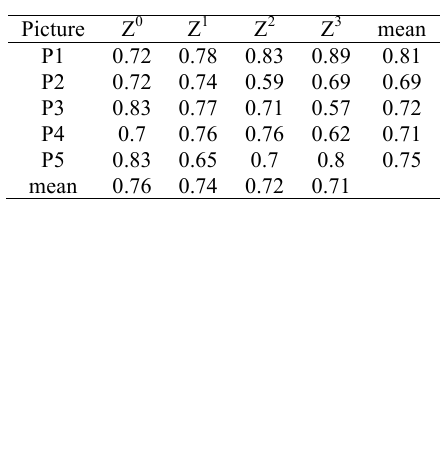
Table 6. Classification accuracies for SVM-MLP method, 3- best features selected using